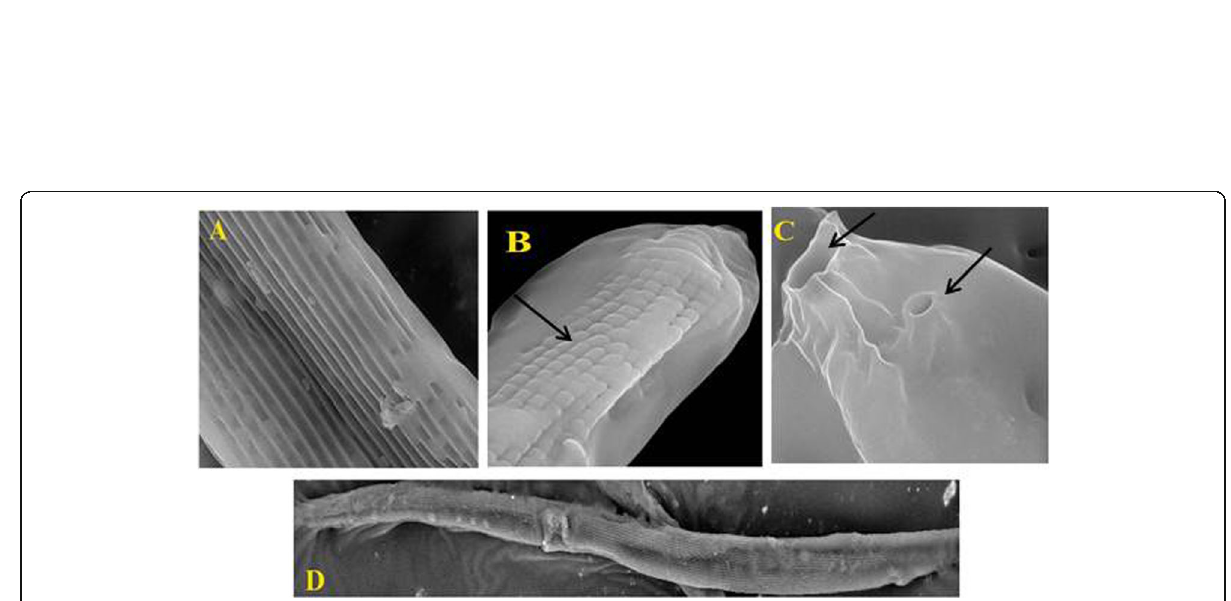
Fig. 4 Heterorhabditis indica . a Longitudinal ridges in the dorsal. b Arrows represent the tessellate anterior region with the mouth. c Arrows represent the mouth and papillae. d Infective